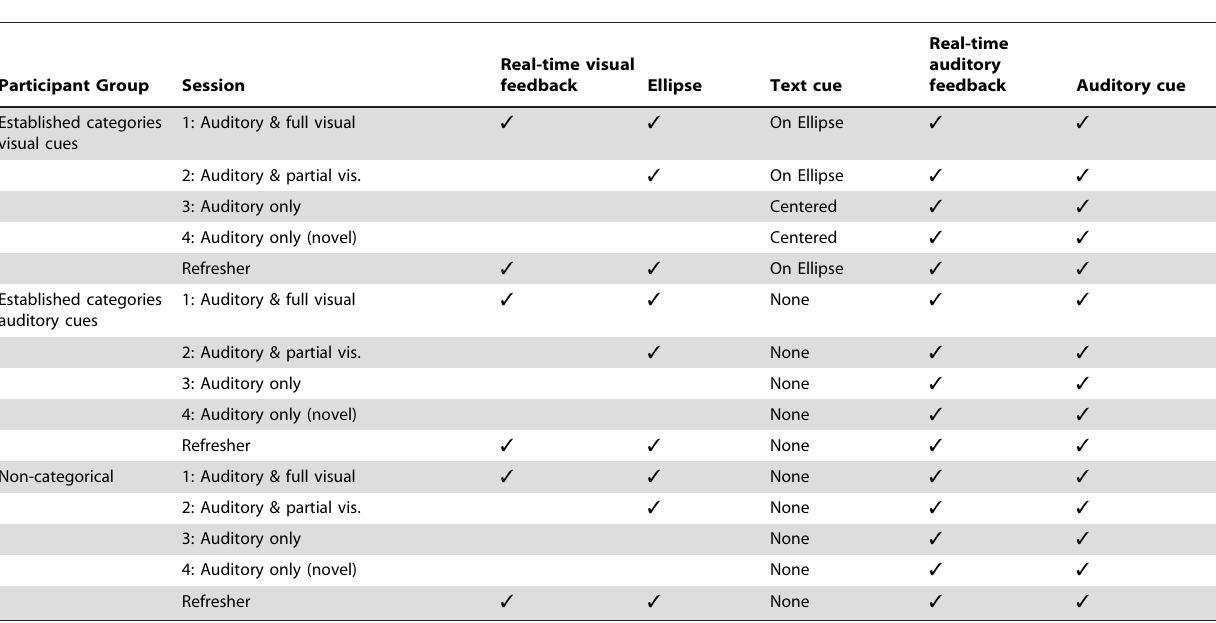
Table 1. The four sessions for the two different training groups (categorical and non-categorical) used different levels of audio- visual